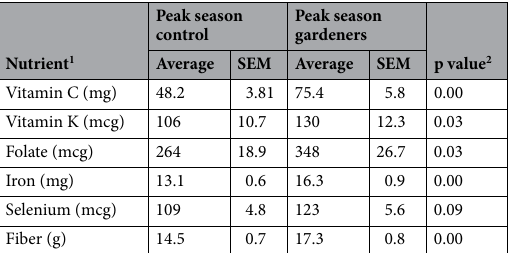
Table 3. Diet record nutrient differences at peak gardening season between gardening and control families. 1 Average nutrient values ± SEM. 2 Two-sided Wilcoxon test.